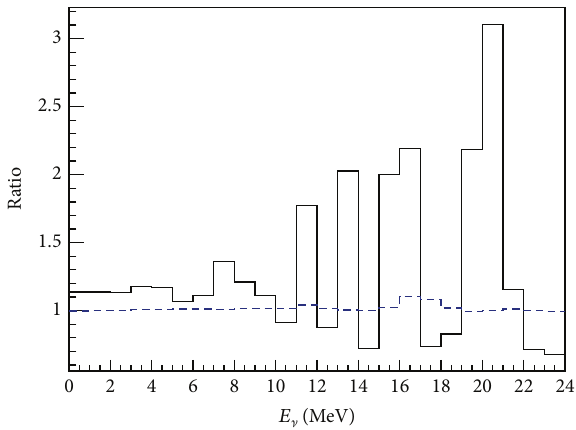
Figure 4: Here the difference due to the Earth matter effect in the observednumberofelectronsisplotted(assuminganinitialfluxthat only contains electron neutrinos). The difference is defined to be the ratio of the observed number of electron type neutrinos for the case where there is a maximal Earth matter effect (impact parameter is sin (. 576 ) ) and the case where there is no earth matter effect. Shown are two curves, black solid for 𝑃 𝐺 = 0 (propagation decoherence case) and blue dotted for the 𝑃 𝐺 = 1 (quantum decoherence case). This calculation was done with a uniform distribution of decoherent electron neutrinos. The difference due to the Earth matter effect may be higher than 300%. In the case of fixed 𝑃 𝐺 = 1, the flavor composition of the neutrino flux is minimally affected by the Earth at low